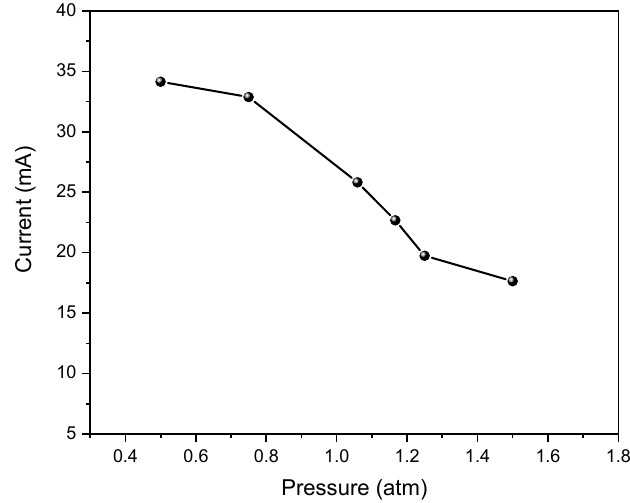
Figure 17. Discharge current variation at different pressures.